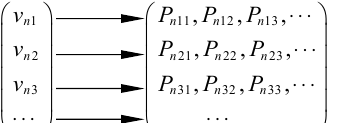
8 of 25 Table 2. Data pre-processing methods. Scatter Plot Based on Raw Data Preliminary Data Filtering and Compensation Secondary Data Filtering Based on Binning Partition 4